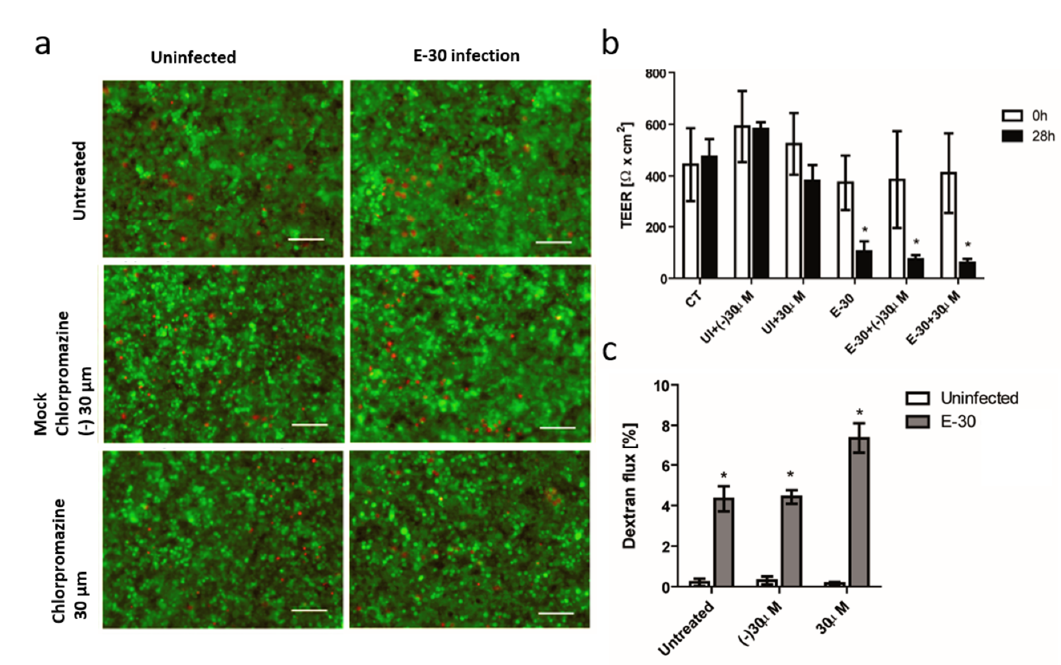
Figure 9. Blocking of clathrin-mediated endocytosis with chlorpromazine has no impact on the loss of barrier properties of HIBCPP cells following E-30 infection. ( a ) Chlorpromazine and E-30 infection have no drastic impact on HIBCPP cells viability. Live / dead assay stains living cells in green and dead cells in red. Pictures show representative images from 3 independent experiments, each performed in duplicates, for the following conditions; control no E-30 infection and no blocking (CT), negative control of chlorpromazine at 30 µ M in uninfected condition (UI + ( − ) 30 µ M), chlorpromazine at 30 µ M in uninfected condition (UI + 30 µ M), E-30 infection (E-30), negative control of chlorpromazine at 30 µ M in E-30 infection (E-30 + ( − ) 30 µ M), chlorpromazine at 30 µ M in E-30 infection (E-30 + 30 µ M). ( b ) TEER decrease after E-30 infection in presence or absence of chlorpromazine. TEER was monitored at T = 0 h (white bars) and T = 28 h (black bars) of the blocking with chlorpromazine, for all the conditions. ( c ) Increased dextran flux following E-30 infection in presence or absence of chlorpromazine. Quantification via fluorescent measurement of paracellular flux with dextran-TexasRed (MW 1000 Da), from T = 24 h to T = 28 h of blocking with chlorpromazine for all the conditions. Statistical significance was calculated using Student’s t -test. p values are displayed as follows: * p < 0.01. White scale bars represent 100 μM.